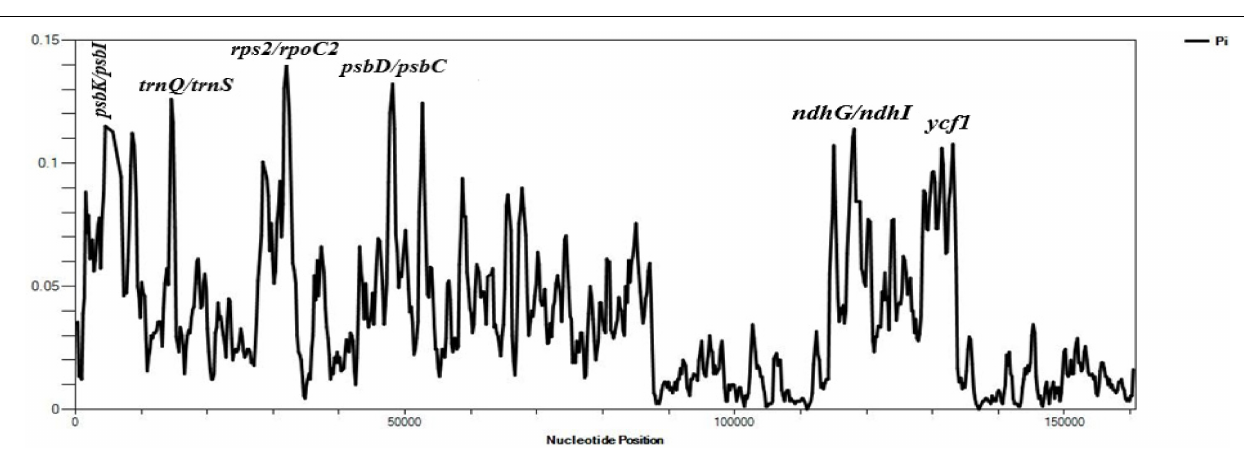
ndhK / ndhC , atpB / rbcL , ndhD , ndhG / ndhI , trnA-UGC , ycf1 .